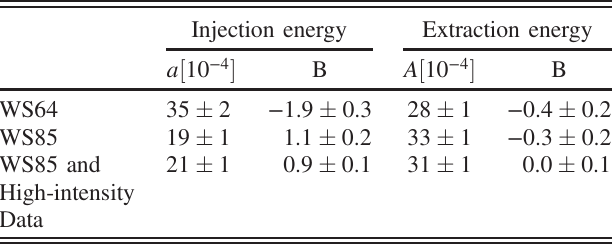
measurement.TABLE I. Parameters of the straight line ϵ y ð N where ϵ y is the vertical emittance of the beam and N intensity, best fitting the data plotted in Fig. 8. Results for the injection and extraction energy are shown. For data measured with WS85 two cases are considered, namely either including or not the high-intensity